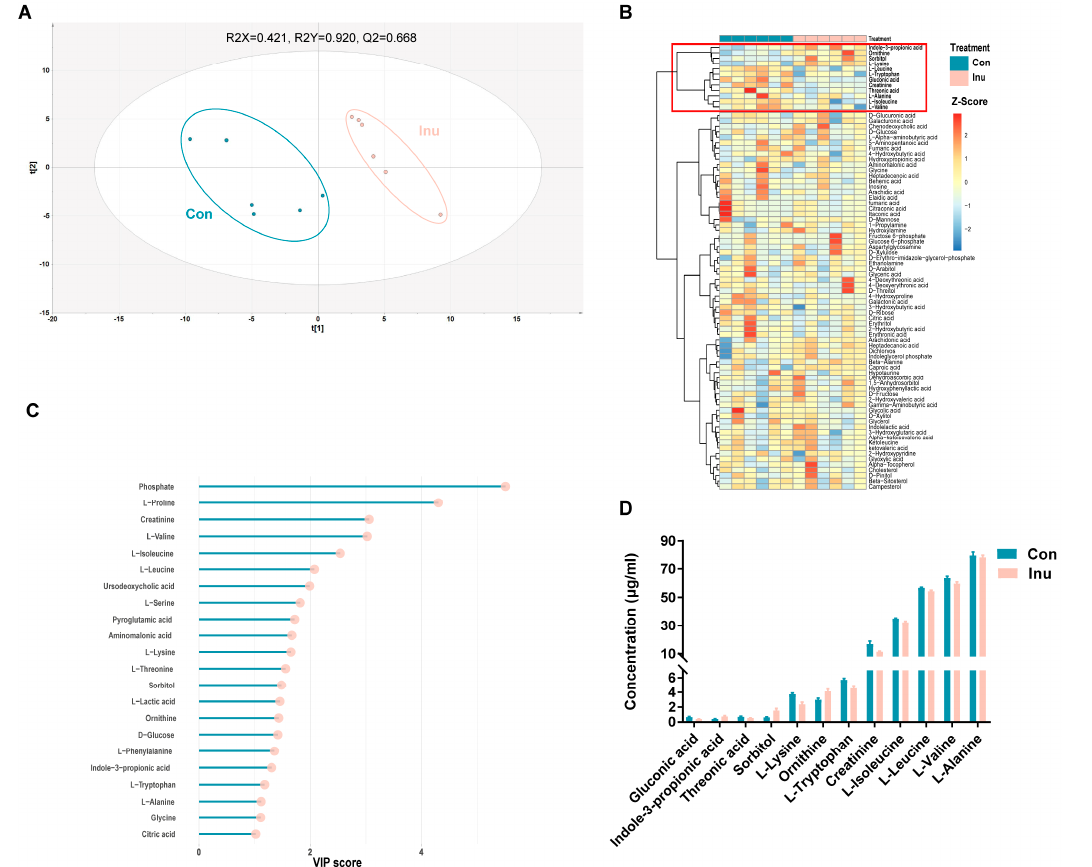
Figure 5. Comparison of plasma co-metabolites in growing pigs fed a diet with or without a 5% inulin supplement ( A ) partial least squares discriminant analysis (PLS-DA) score plot comparing control and inulin. ( B ) Hierarchical clustering result shown as heatmap (distance measure using Euclidean, and clustering algorithm using Ward’s linkage). ( C ) VIP scores estimated from PLS-DA model. Only co-metabolites with a VIP score > 1 were shown. ( D ) Plasma serum co-metabolites which were significantly different between control and inulin. Con, control; Inu, inulin.